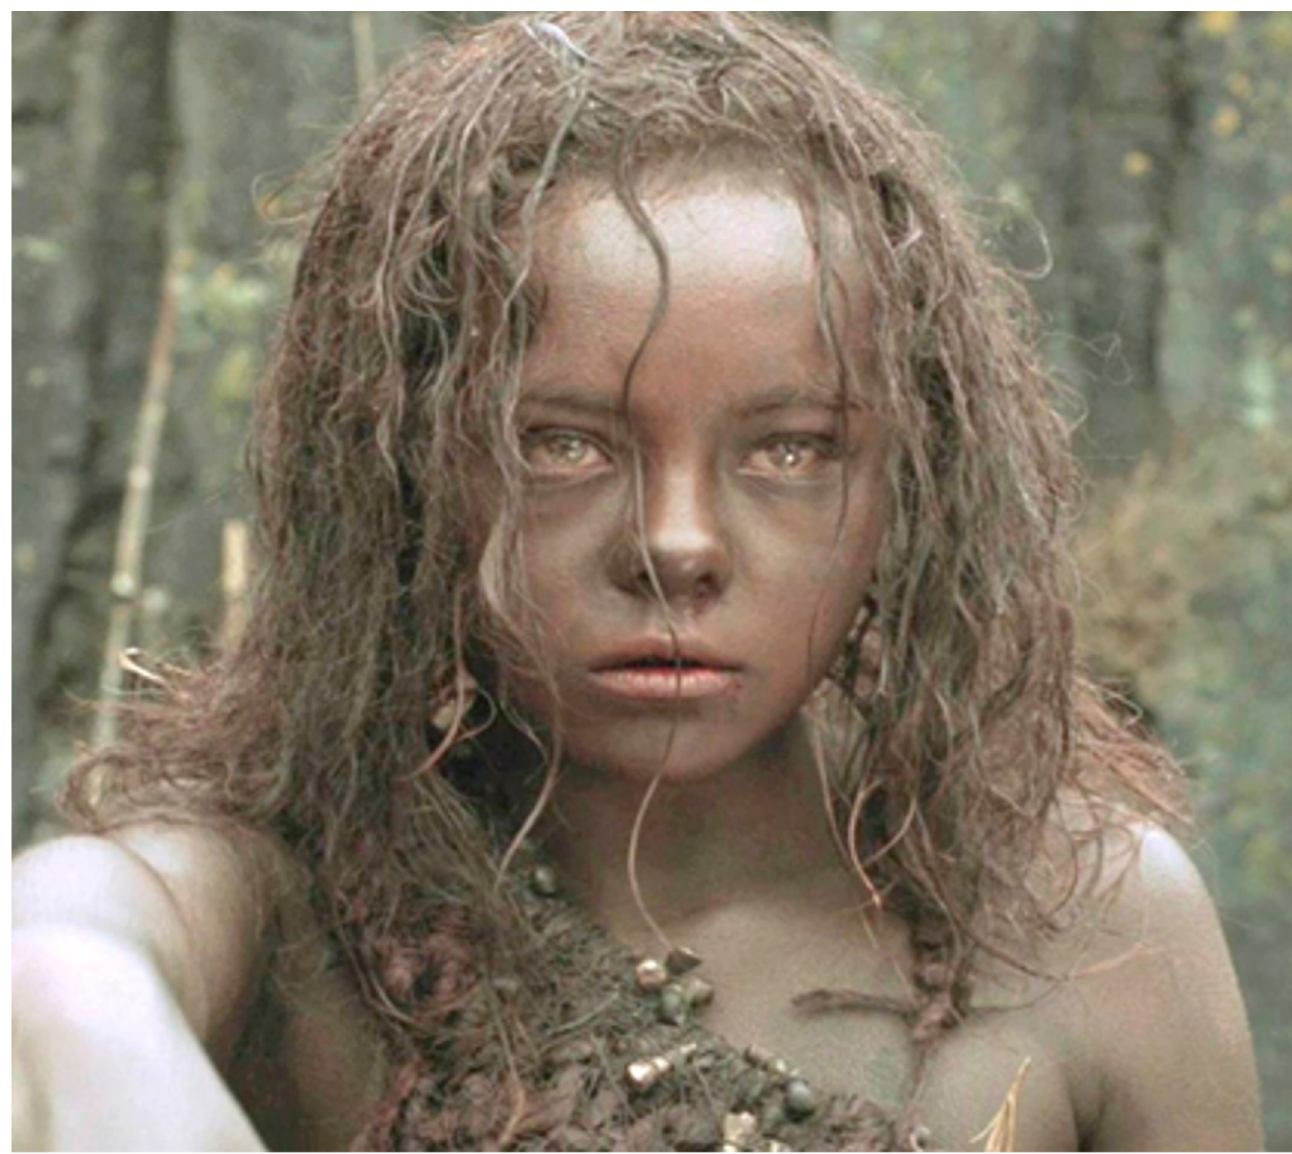
Figure 16. The daughter of the witch (2005). https://www.pinterest.es/pin/247205467020036176/ (accessed on 1 January 2021).